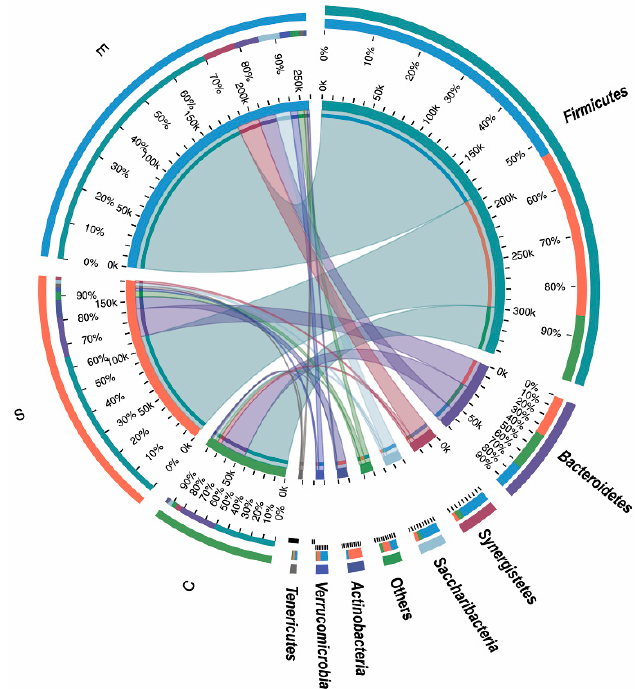
Figure 3. Distribution of the microbial communities in each group at the phylum level. Samples in different groups are on the left side, and the phyla are on the right side. The first and second colorful circles (circles from the outside to the inside): the left half of the circle represents the relative abundance of phyla in different groups, different colors represent different phyla, and the length represents the ratio of the abundance of a phylum in a given group (percentage shown in the second circle); the right half of the circle indicates the proportion of groups in a given phylum, different colors represent different groups, and the length represents the proportion of groups associated with a given phylum (percentage shown in the second circle). The third circle: one end of the color band in the circle is connected to the group from a given phylum (left half circle), the width of the end point of the band indicates the abundance of a different phylum in a given sample, and the other end is connected to the phylum (right half circle). The width of the end point of the band indicates the proportion of different groups in the corresponding phylum.